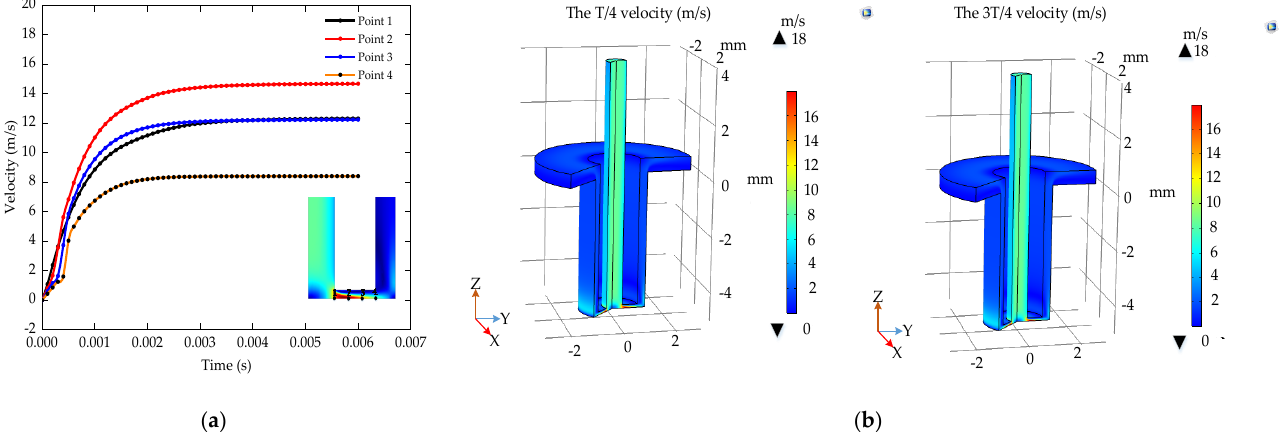
Figure 6. The velocity distribution of the pulse ECM; ( a ) the velocity change rules of reference points; ( b ) the velocity during a pulse period.